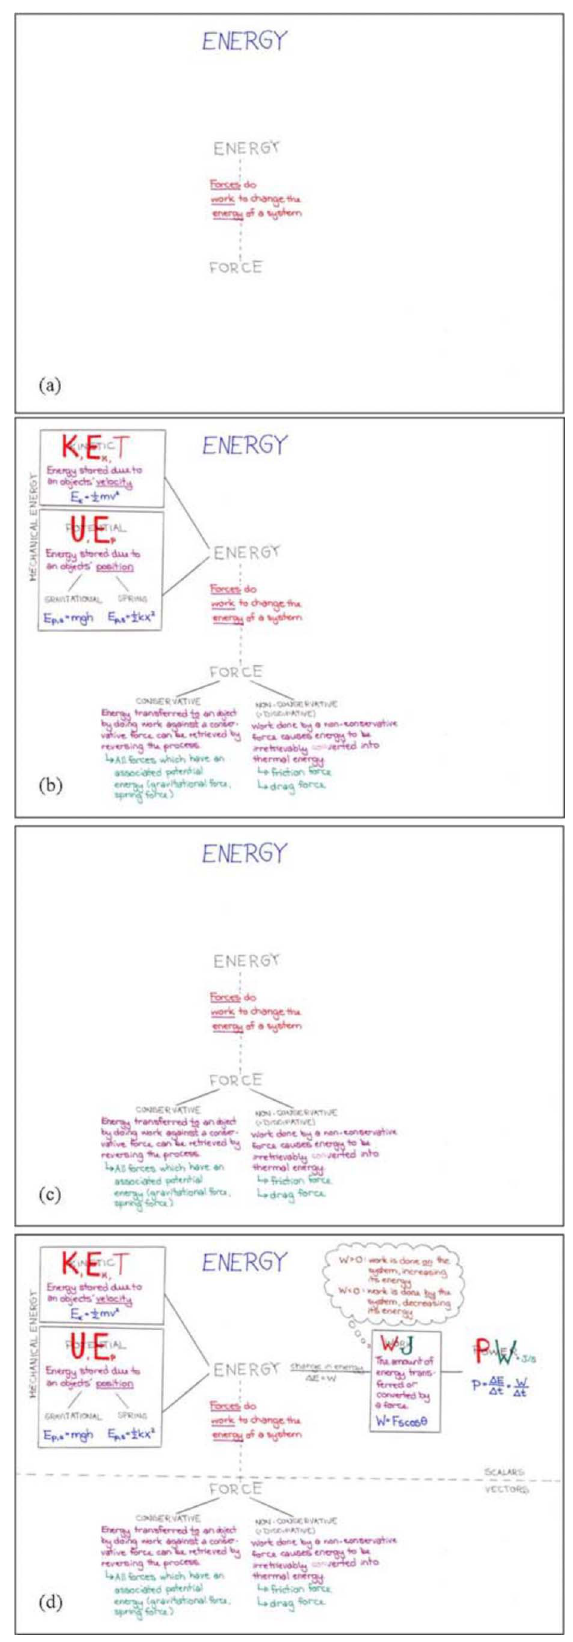
FIG. 3. (cid:1) Color online (cid:2) An illustration of the layering that was used to present the link maps in map